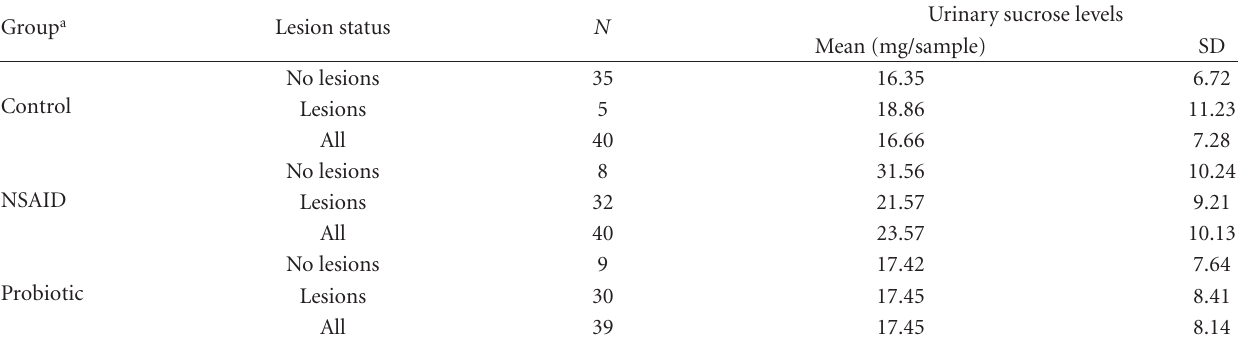
Table 3: Urinary sucrose levels of rats grouped according to lesion status.